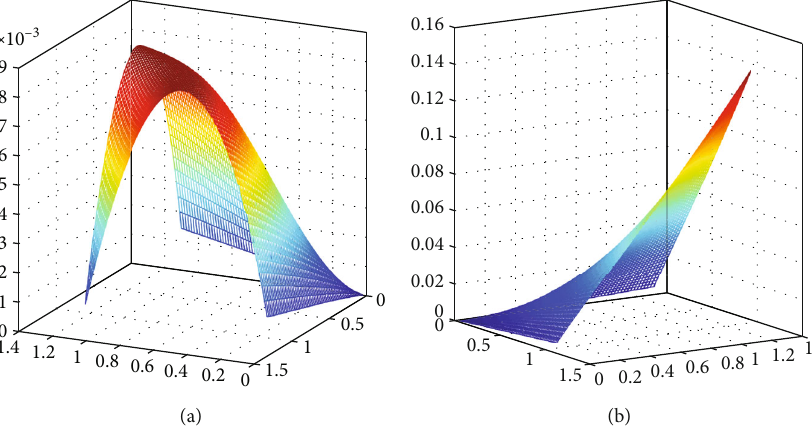
Figure 1: The solution ϑ = ð ϑ The norm k ϑ k = 3 : 473 .